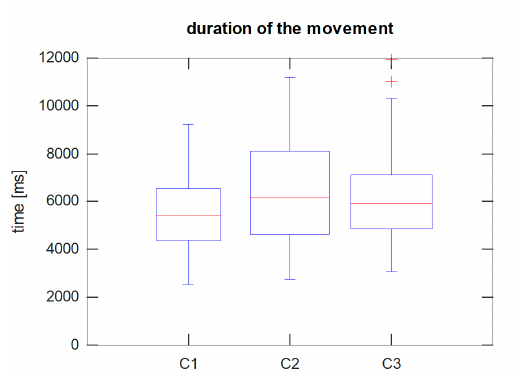
Figure 2. Duration of the movement for the three categories (C1, C2 and C3). The figure shows the calculated minimum, 1st quartile, median (red line), 3rd quartile and maximum for every